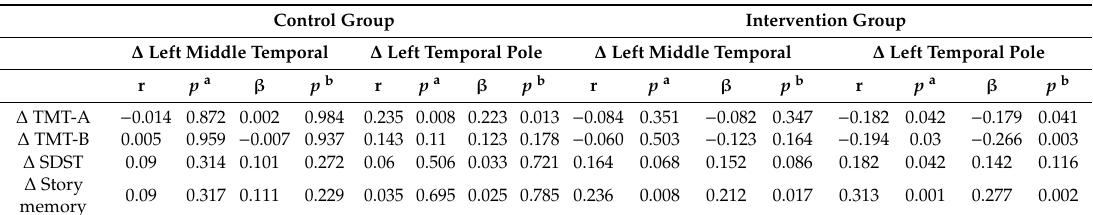
Table 3. Relationship between change in cortical thickness and cognitive performance in control and intervention groups.